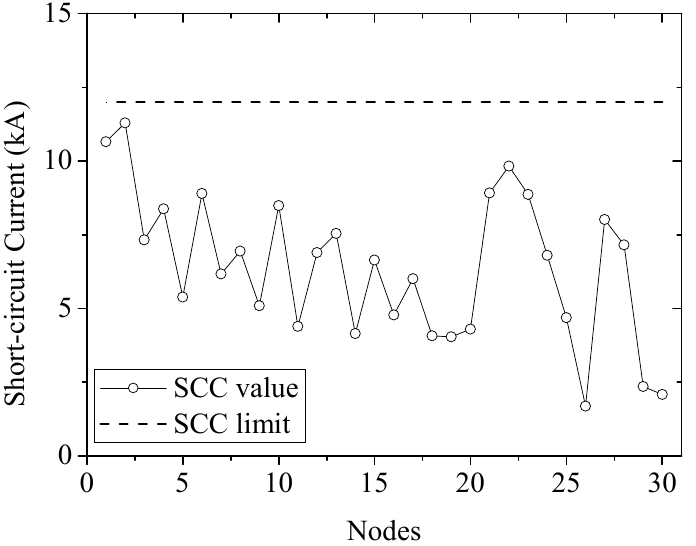
Figure 3. The short-circuit current magnitudes of all the buses in IEEE 30-bus system after transmis- sion switching.